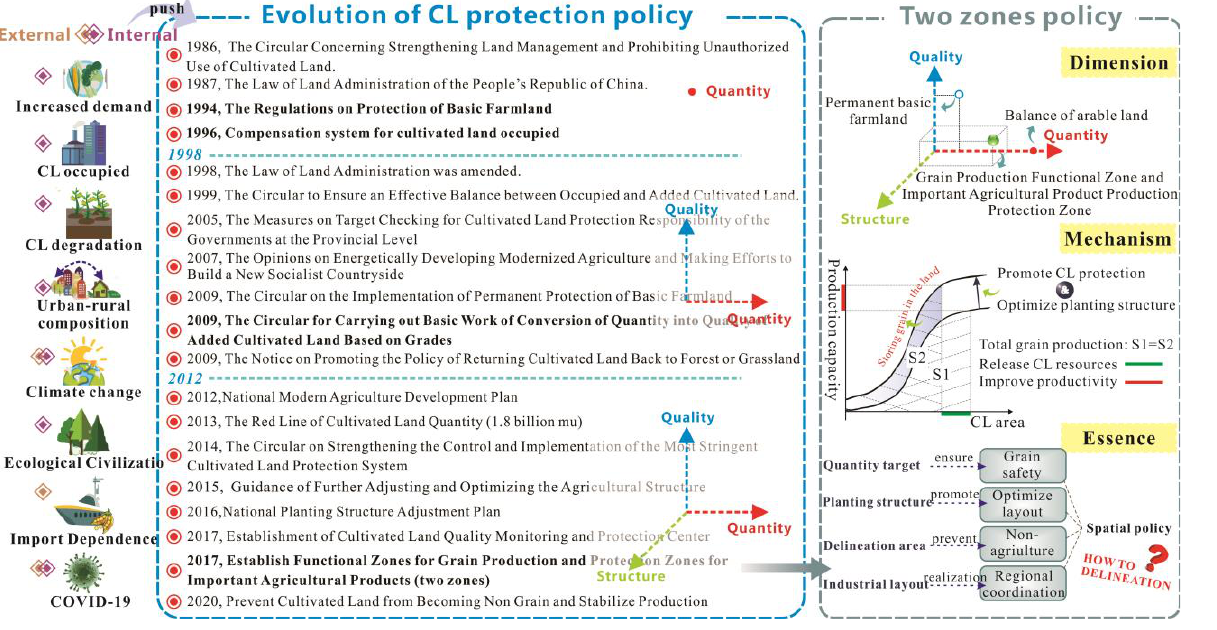
Figure 1. Formation of the trinity of quantity, quality, and structure of the CL protection policy.